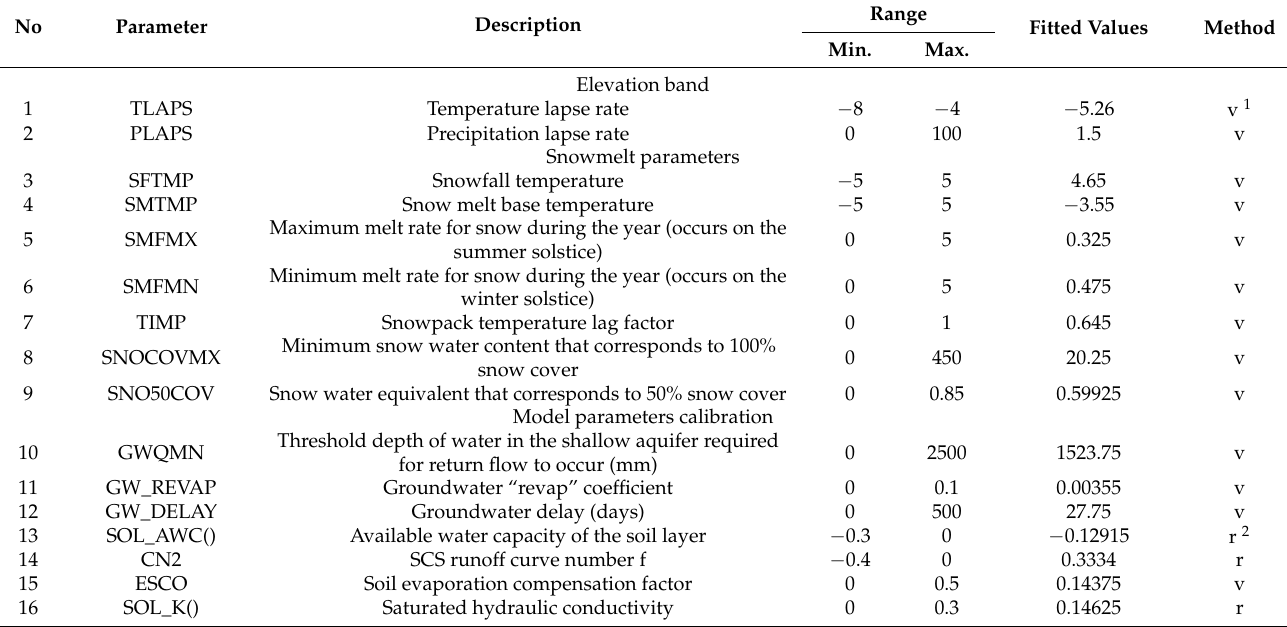
Table 2. Parameter ranges and fitted values for the model calibration in the